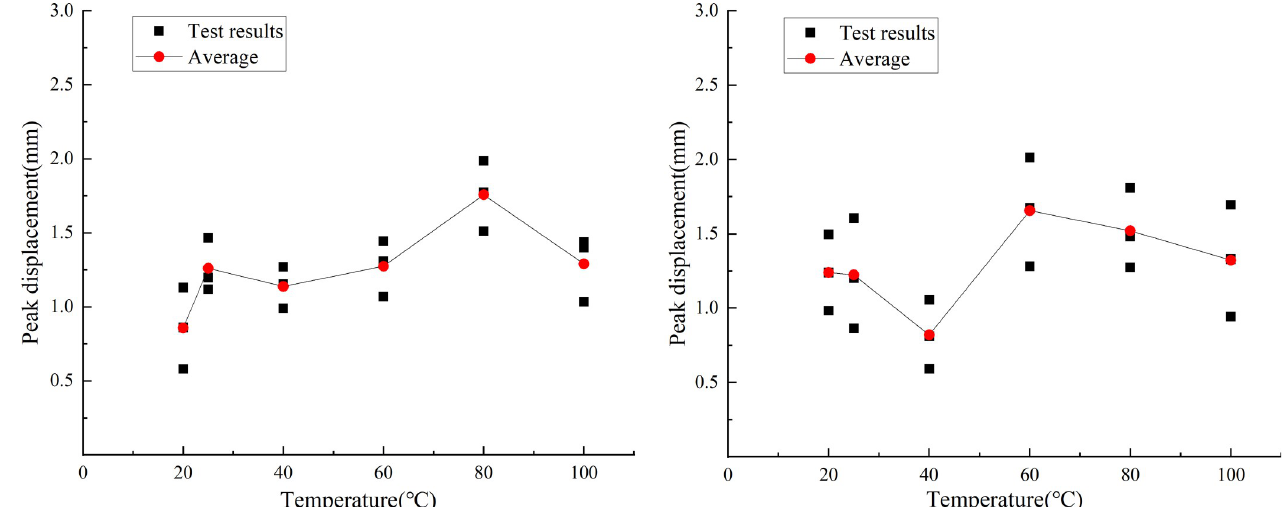
Fig 22. Peak displacement curve at different temperatures. (a) Compressive strength responses of rockburst-like materials. (b) Raw rock.